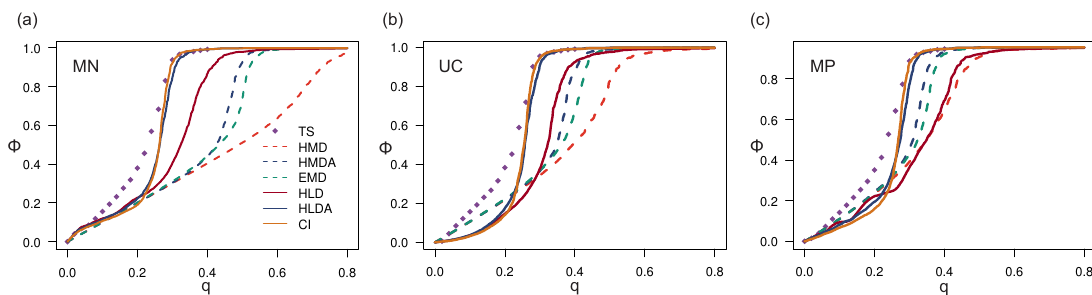
Figure 3. Optimal disintegration strategies in coupled ER networks with different degree correlation under layer node-based attack. The two layers are obtained independently with probability p = 0.006 and size N = 500. The two layers are coupled with there correlated structure (MN, UC and MP), in figures ( a–c ) respectively. We determine the mean value of Φ over 20 independent realizations.